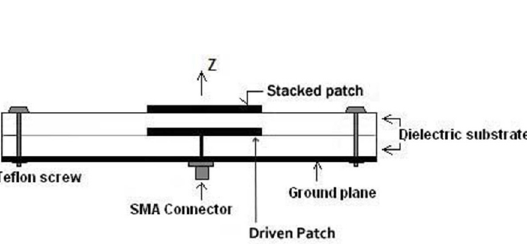
Figure 3. Top and side views of stacked antenna geometry without airgap.